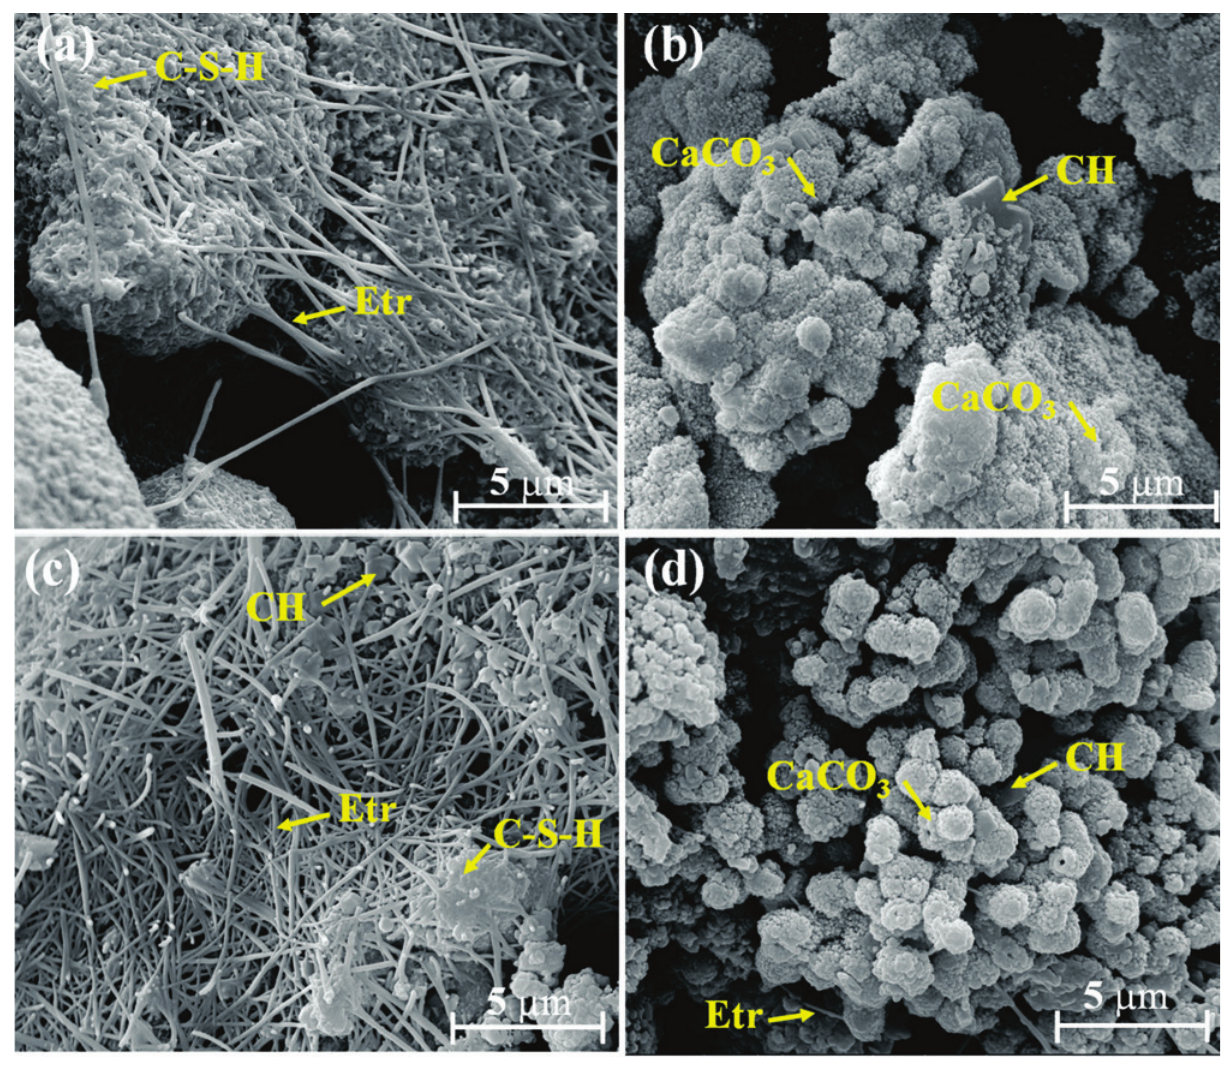
SEM of mortars after 7 days of curing at magnification of 12.000x. (a) REF_WT. (b) SP_IM. (c) REF_PB and (d)